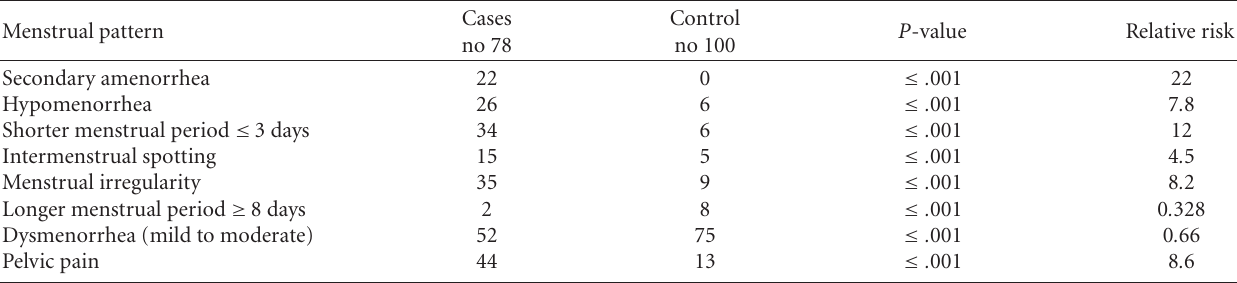
Table 1: Comparison of menstrual patterns in the women, with (cases) and without tuberculosis (controls). Cases Menstrual pattern